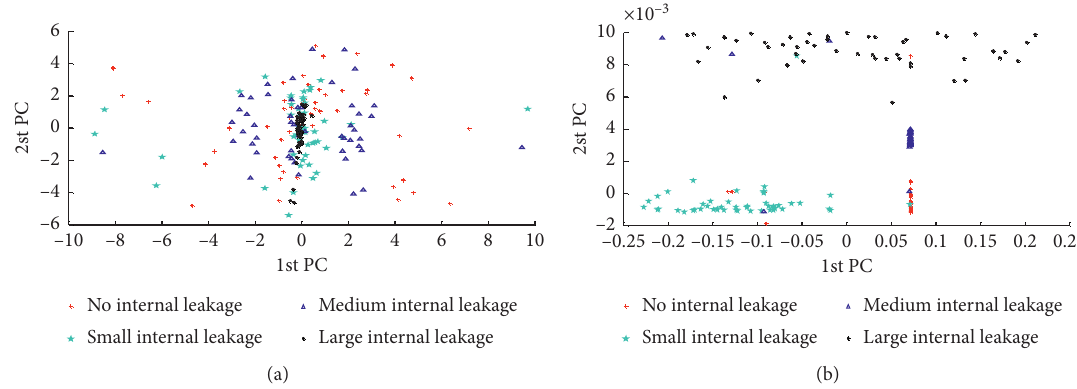
Figure 8: 2D-PCA projection of the testing samples of dataset A. (a) Input data. (b) Third hidden layer.